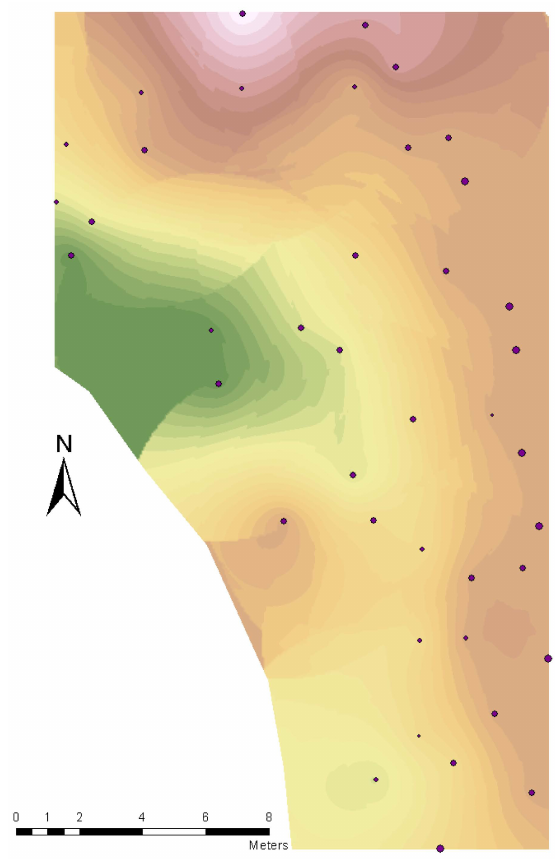
Figure 2. Scheme of tree positions inside plot with the digital surface model based on their Z